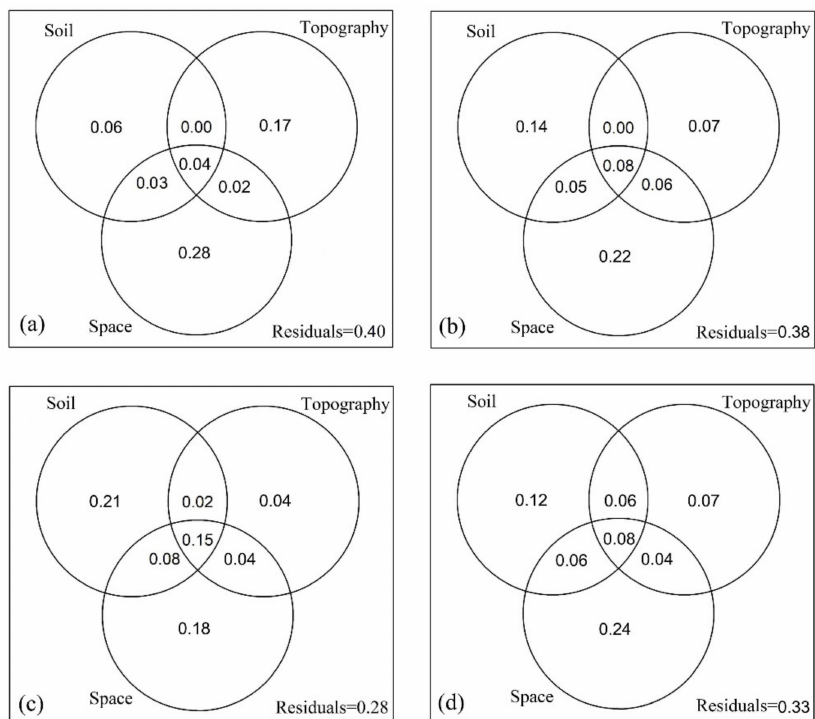
Figure 4. Variance partitioning results of trait dispersion (ZFDis, the standardized e ff ect size of functional dispersion) against the soil, topography and space across three ontogenetic stages and all trees at 20 m × 20 m spatial scale. ( a ) Saplings, ( b ) juveniles, ( c ) adults and ( d ) all trees. 3.3. Trait Dispersions of the Multivariate Trait (AT) For All Trees Across Spatial Scales